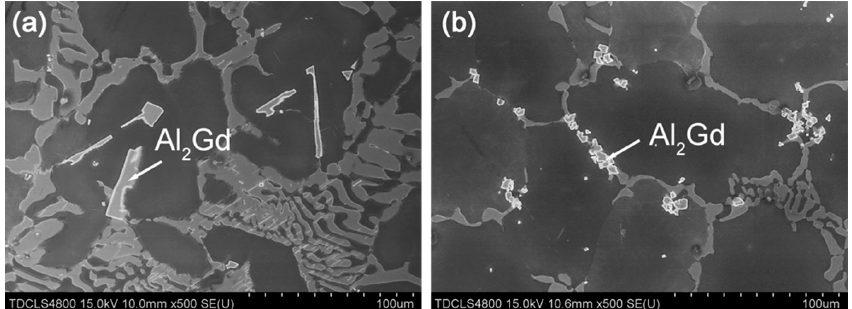
Figure 4. SEM images of the Mg–Al–Gd alloys homogenized at 620 ◦ C and furnace-cooled under ( a ) 0 T